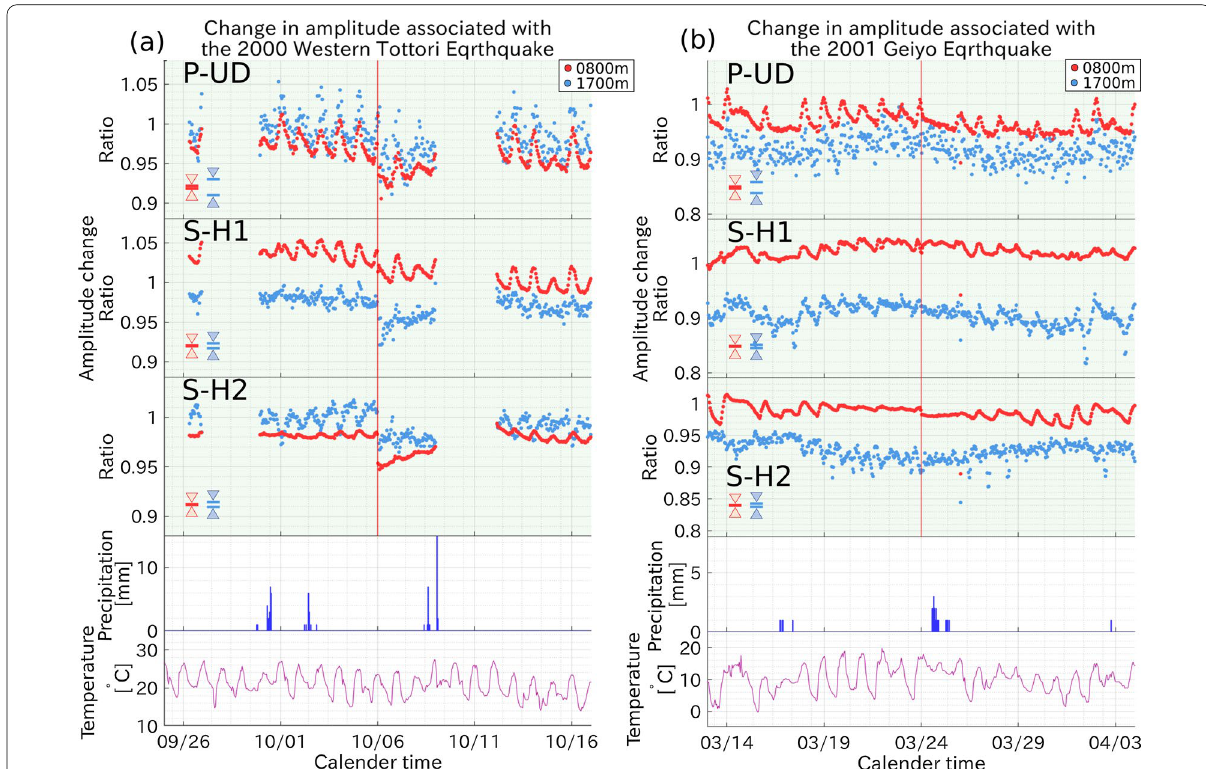
Fig. 6 Changes in amplitudes 10 days before and after the 2000 Western Tottori (WT) and 2001 Geiyo (GY) earthquakes. The bottom row shows the temperature and rainfall at Gunka station. The gap between horizontal lines with a pair of triangles on the left of the panels shows the average error of the amplitude